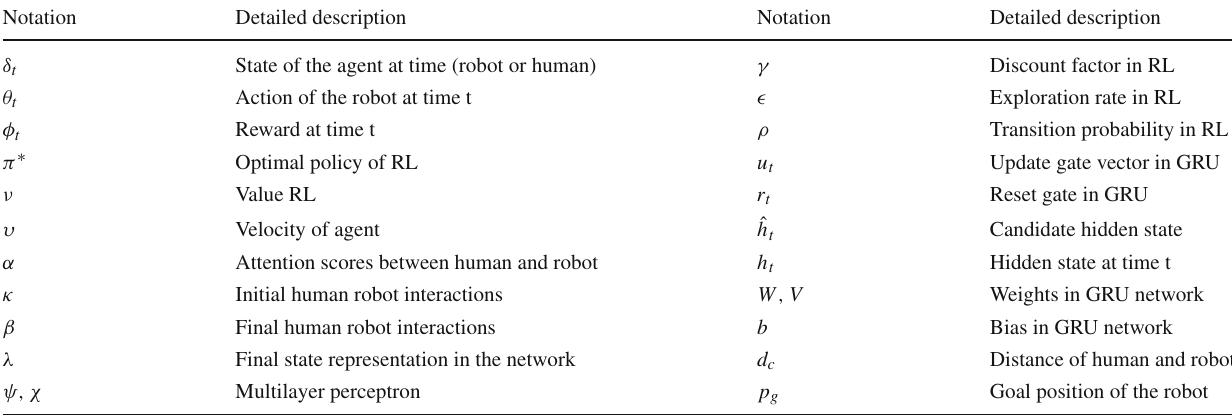
Table 2 The detailed description of all the notations used in this